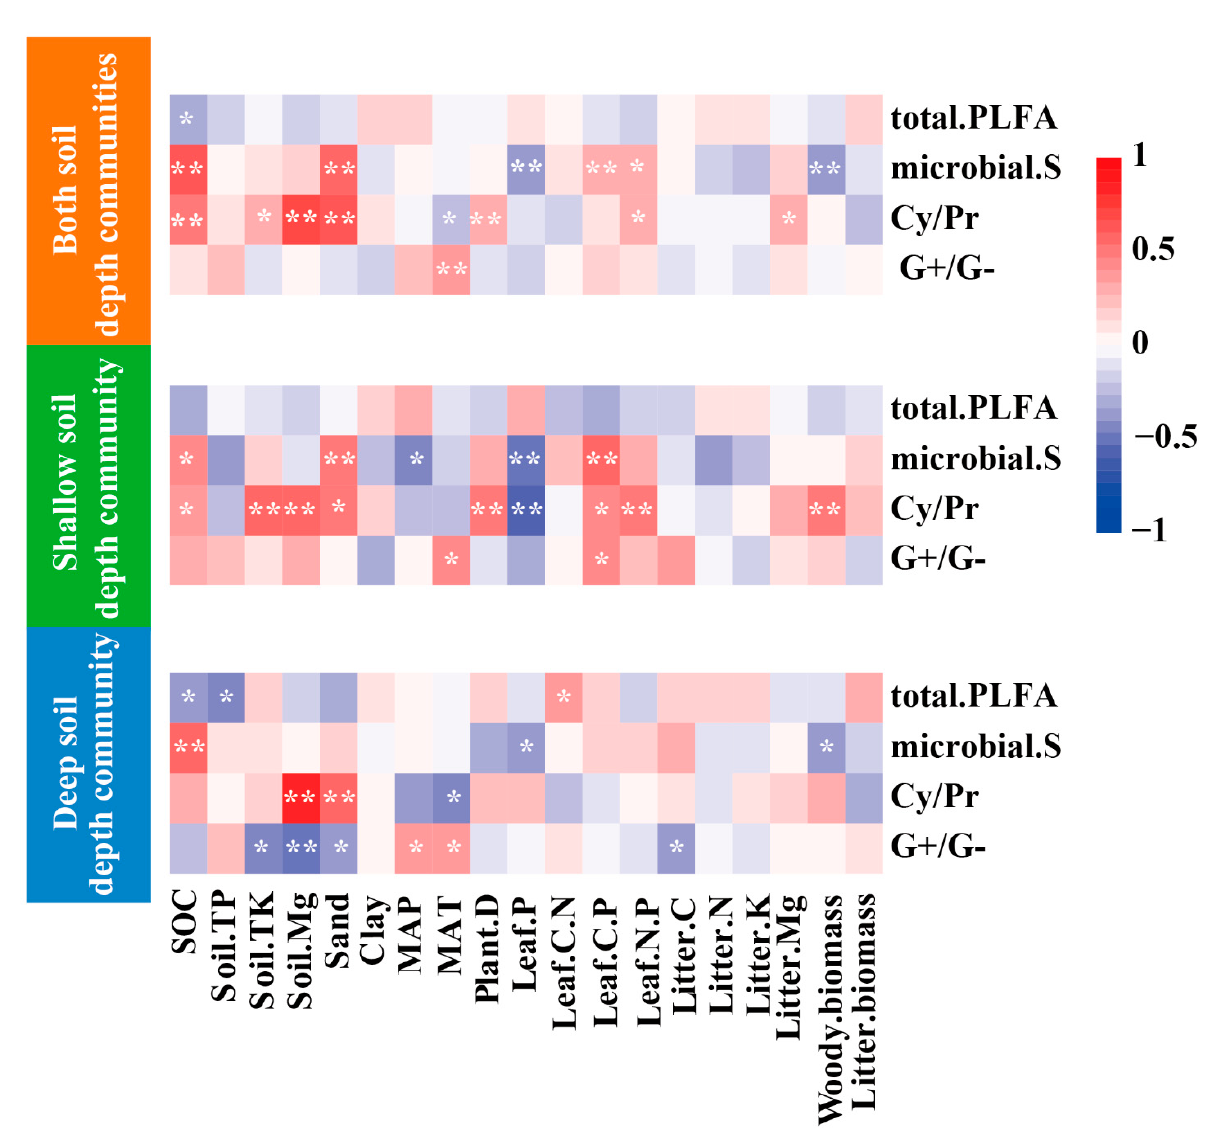
Figure 3. Pearson’s correlation analysis between environment factors and microbial PLFA indices in different soil depth communities. ** indicates significant difference at p < 0.01 level and * indicates significant difference at p < 0.05 level.